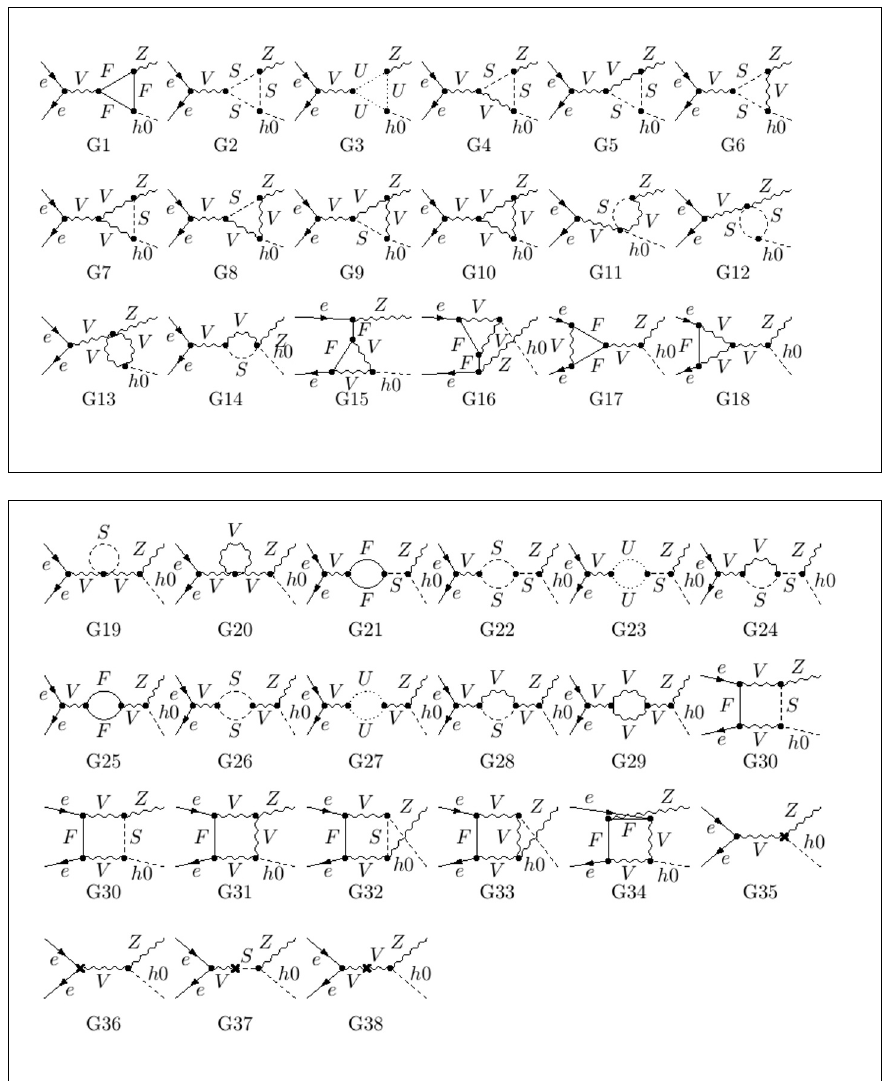
Figure 6 . Generic one-loop Feynman diagrams for e + e − → Zh 0 where F stands for SM fermions, V stands for generic vector boson which could be γ , Z or W ± and S could be either a Goldstone G 0 , G ± or a Higgs boson h 0 , H 0 , A 0 or H ±